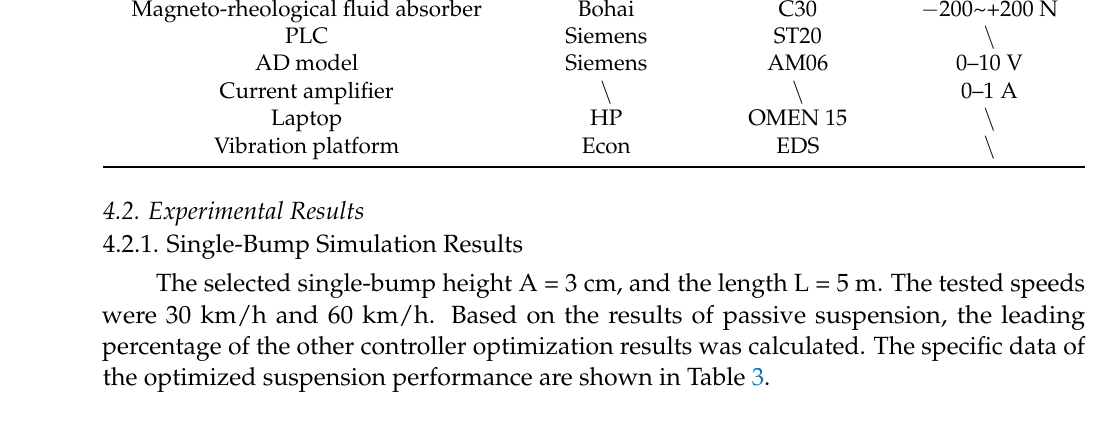
Table 3. Optimization Results for Simulation of the Single Bump.